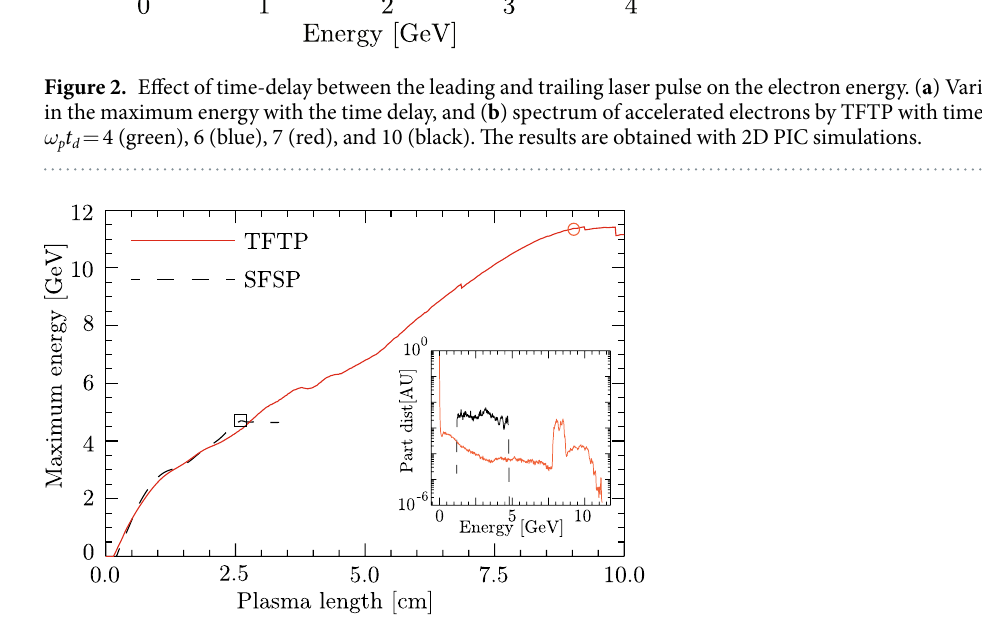
pulse needed to be externally guided through a 1-m long plasma channel with on-axis density of 2 × 10 17 cm − 3 . Similarly, Vay et al . 33 have also shown the possibility of obtaining 10-GeV electron bunch from a 40-J laser pulse, externally guided through a 1.5-m-long plasma channel with on-axis 1 × 10 17 cm − 3 plasma density. In comparison we have shown that two-color dual-stage LWFA can deliver same energies in one-order shorter plasma length. It is worth to mention the concerns on the transverse offset between the two pulse and plasma guiding structure. Such